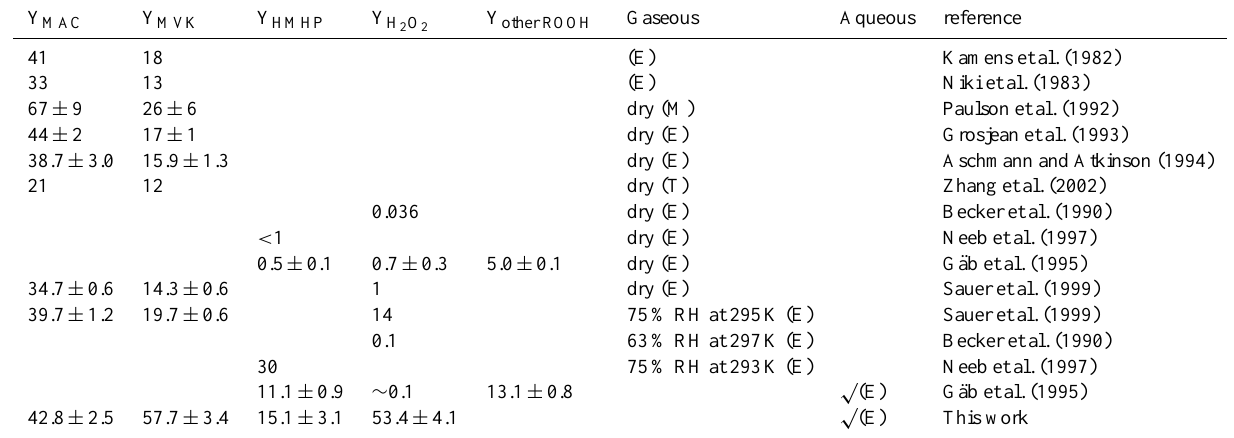
Table 2. Molar yields (%) of MAC, MVK and peroxides in the ozonolysis of isoprene under different conditions. Y MAC Y MVK Y HMHP Y H Y other ROOH Gaseous Aqueous reference 2 O 2 (E) Kamens et al. (1982) (E) Niki et al. (1983) dry (M) Paulson et al.